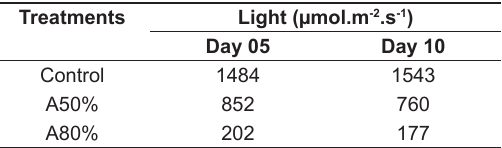
Figure 4. Variation of the biomass of the periphytic algae in the different treatments (AC: Control Treatment, A50: Treatment with 50% shading, A80: Treatment with 80% shading) over time. Table 2. Mean values of luminous intensity in the treatments (Control, A50%: Aquarium with 50% coverage, A80%: Aquarium with 80% coverage) throughout the